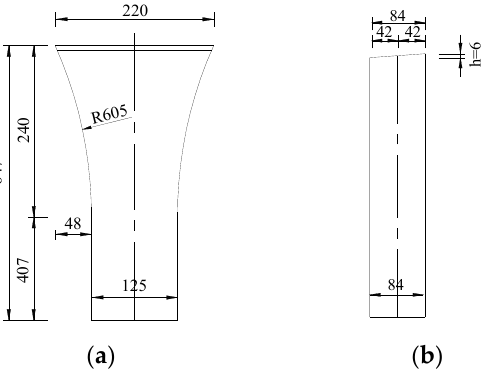
Figure 2. Layout of the test system (unit: mm): ( a ) elevation view; ( b ) plan view.